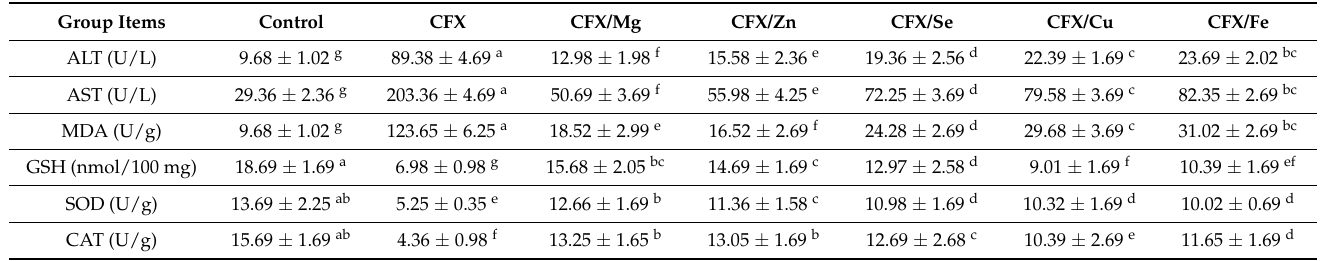
Table 6. Antioxidant enzyme activities in groups treated with either ceftriaxone or ceftriaxone metal